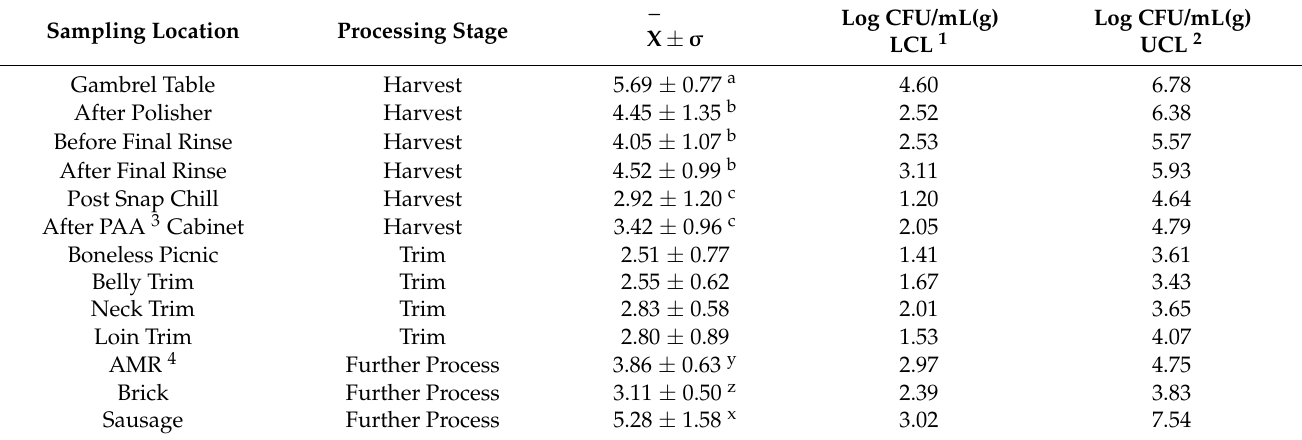
Table 1. Statistical process control parameters for aerobic counts calculated at each sampling location ( n = 5 samples/location) collected during 10 weeks throughout the pork processing